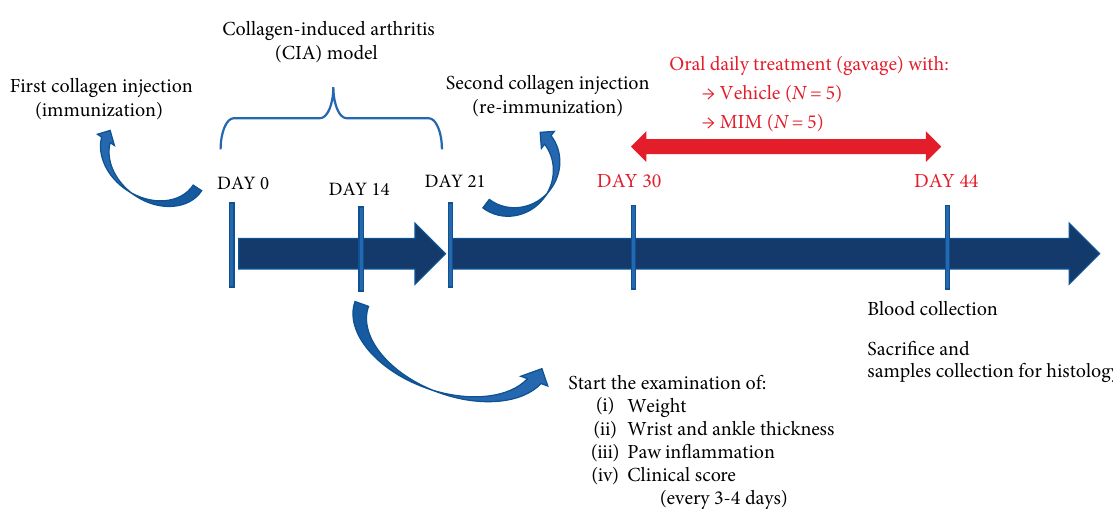
Figure 1: Experimental schema of the in vivo